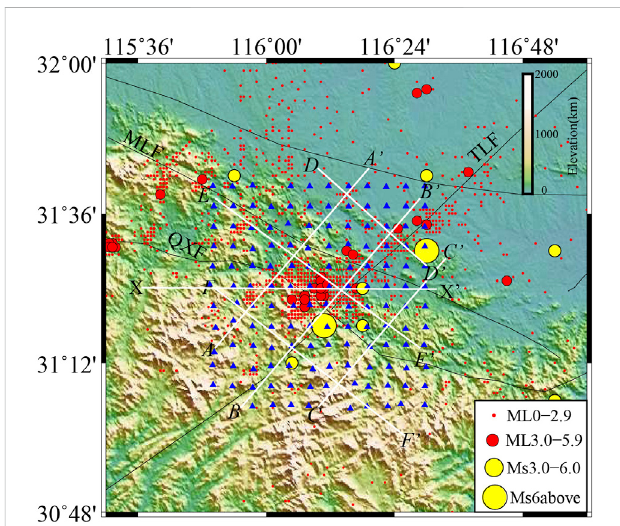
FIGURE 2 Distribution of short period temporary stations and main faults in the Huoshan area and its adjacent areas (Red dots and circles represent earthquakes (ML0 above)after 1970s by instrumental records; yellow circles are the earthquakes have been occurred before 1970s. The white lines AA ’ to FF ’ are the Vs. pro fi les in Figure 9; the lines XX ’ is the vertical pro fi le in Figure